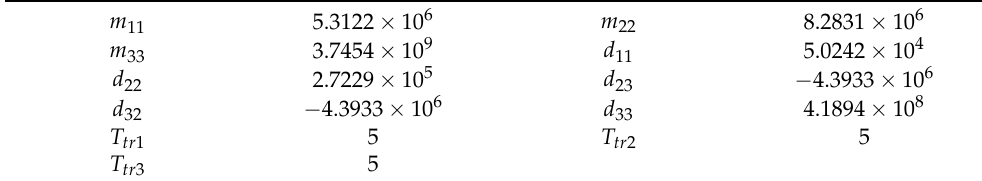
Table 1. Parameter of the supply vessel Northern Clipper .